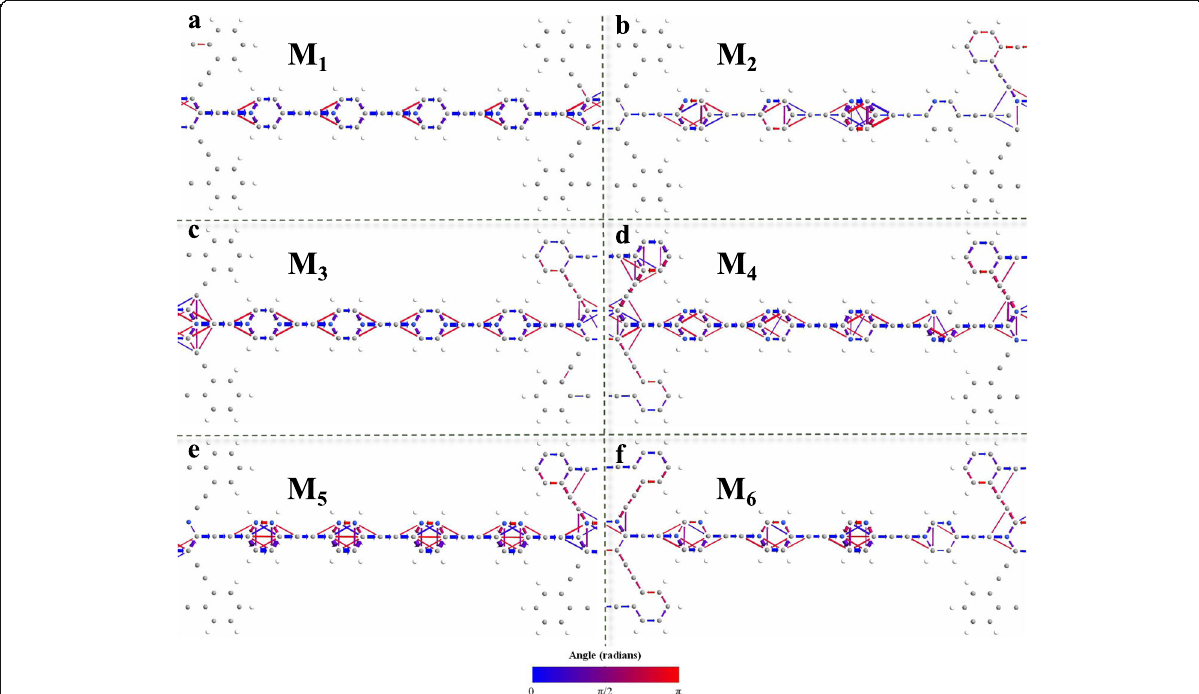
Fig. 3 (Color online) The transmission pathways of N-doping A γ GYNRs as M 1 – M 6 with four periodic molecular chain named as D in the central region. In the views of a – f , the colors of connecting arrows between two atoms give the hopping direction of electron transmission according to the drawn color bar, and the successive different colors correspond to a series of different angles. The threshold is taken as